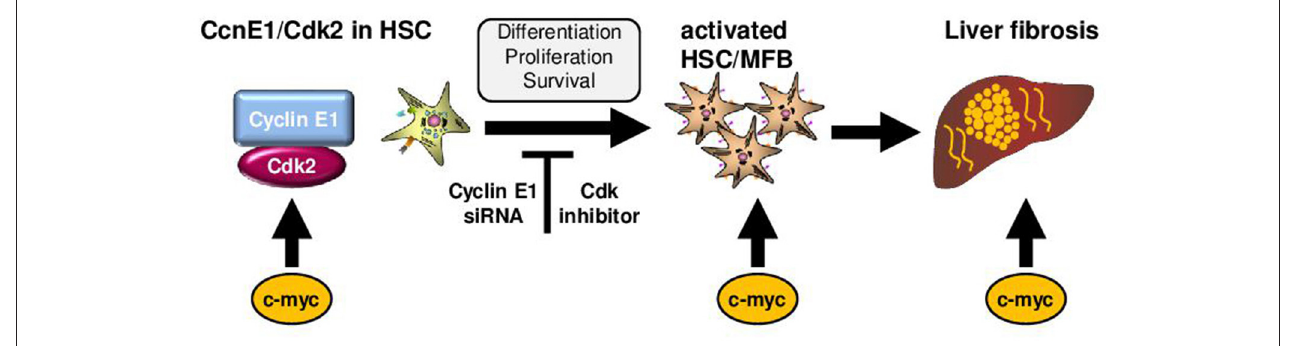
FIGURE 2 | Role of cell cycle mediators for liver fibrosis initiation. Initiation of liver fibrogenesis is associated with increased hepatic cell cycle activity in HSCs. Important cell cycle mediators in these processes are c-myc and the Cyclin-dependent kinase 2 (Cdk2) in complex with its regulatory subunit Cyclin E1. In general, c-myc is involved in activation of Cyclin E1/Cdk2. Moreover, over-expression of c-myc in hepatocytes triggers activation of HSCs and is observed in patients and mice with liver fibrosis. Cyclin E1 is indispensable for initiation of liver fibrosis and also essential for proliferation, differentiation and survival of HSCs. Direct targeting of Cyclin E1 is currently feasible by using RNA interference (siRNA) in vivo . Anti-fibrotic effects in HSCs can also be triggered by the use of pharmacological inhibition of